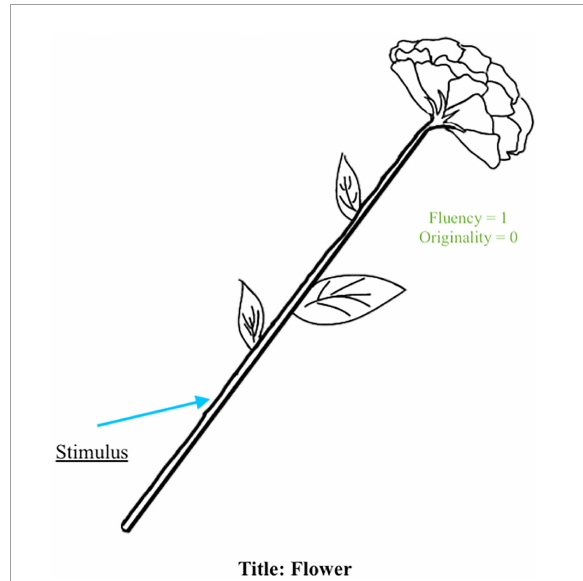
FIGURE1 Example of a response where the stimulus is identifiable and used as part of the idea (i.e.,